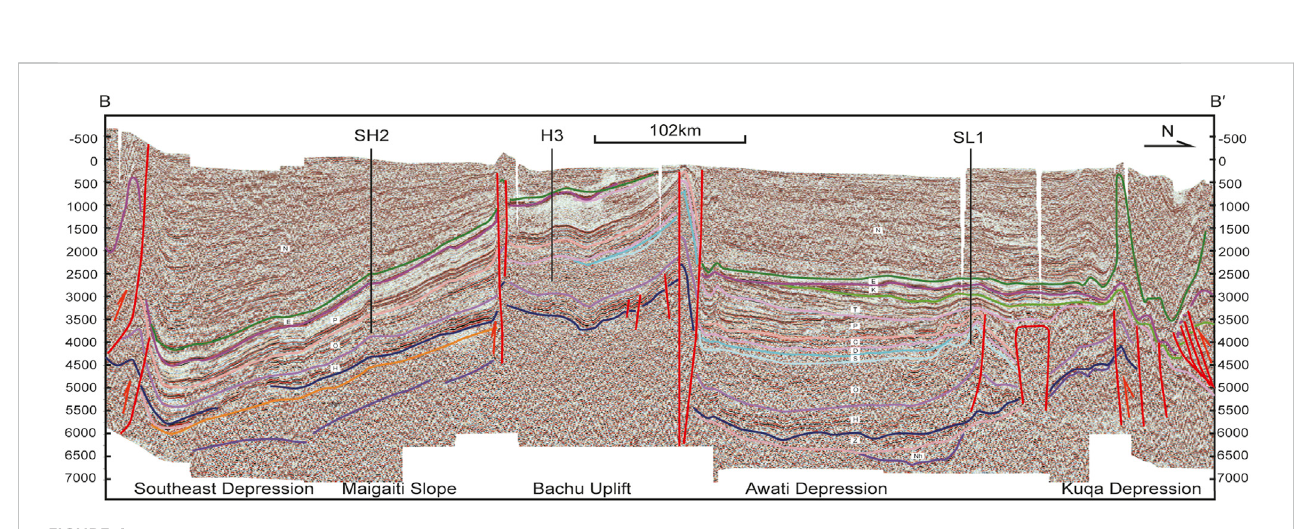
FIGURE 4 Geological interpretation of seismic section BB ’ . The location of this seismic section is shown in Figure